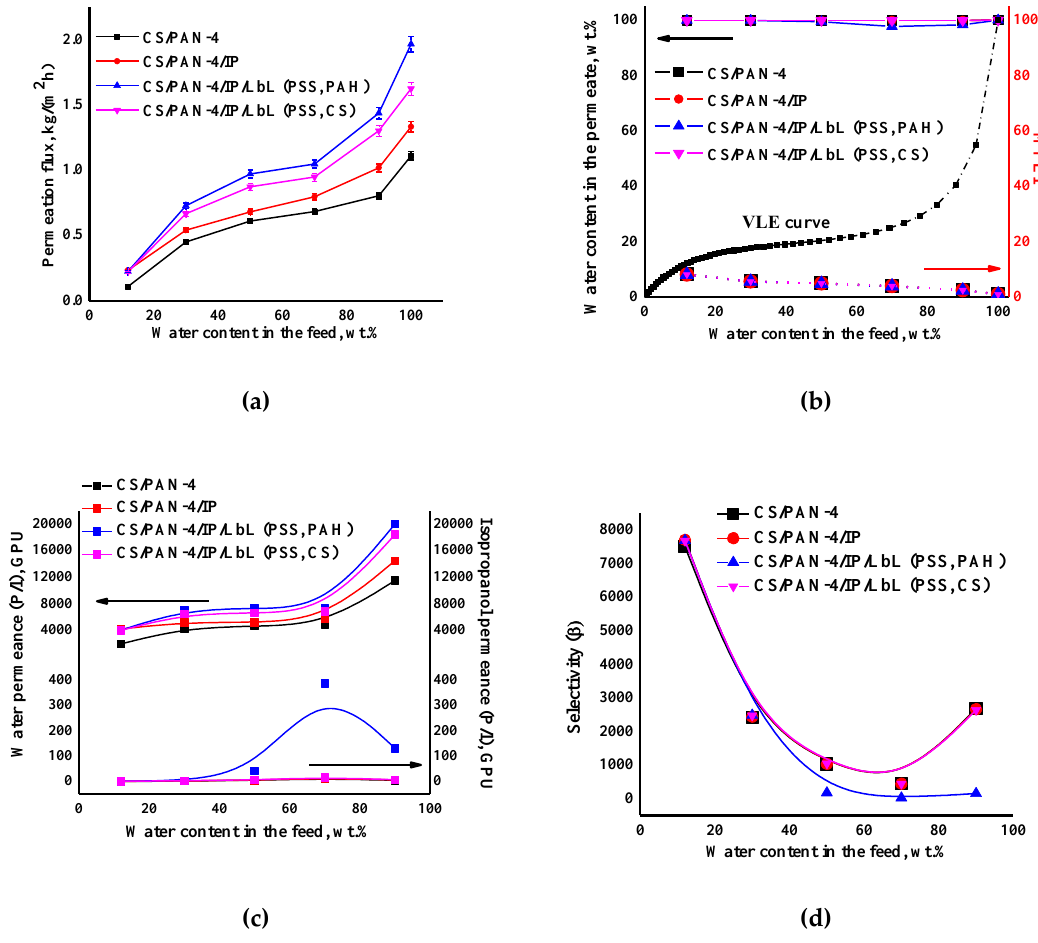
Figure 11. The dependence of ( a ) the permeation flux, ( b ) water content in the permeate and MFLI, ( c ) component permeances and ( d ) selectivity on water content in the feed in pervaporation for separation of isopropanol-water mixture using the reference CS / PAN-4 and unmodified and modified by five bilayers PEL (PSS / PAH or PSS / CS) CS / PAN-4 / IP membranes. The vapor–liquid equilibrium (VLE) was calculated using Aspen software. The mean accuracy was < ± 0.5% for water content in permeate and < ± 3% for permeation flux.